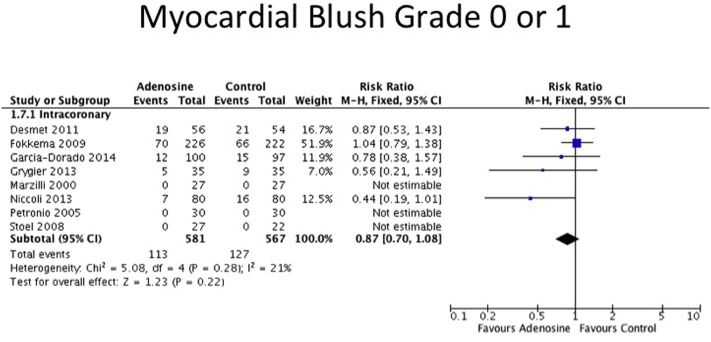
Forest plot for TIMI flow < 3, adenosine v control.